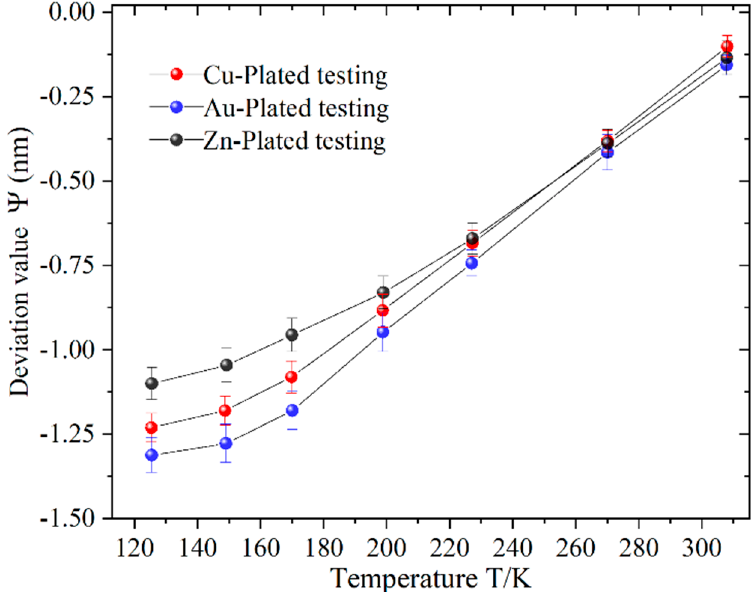
Figure 6. Sensitivity of wavelength to temperature in different packaging materials.